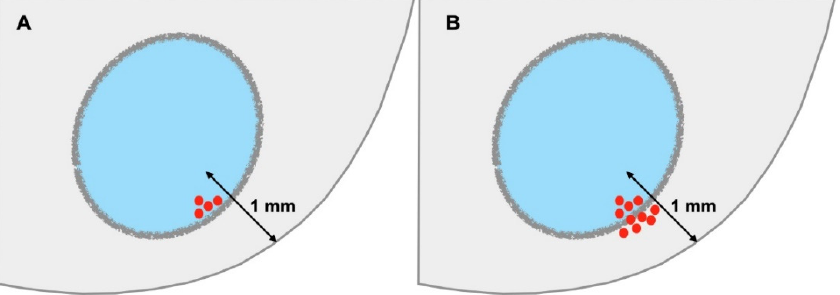
Figure 2. R1 and mode of cancer spread. A lymph node metastasis separated by ≤ 1 mm from the margin is not considered R1 as the tumour lies within a segregated microanatomical compartment ( A ). Only when there is extranodal growth, i.e., cancer cells grow outside the boundaries of the lymph node compartment at 1 mm or less from the margin, is the risk for residual cancer in the surgical bed increased, and the finding is to be reported as R1 ( B ).